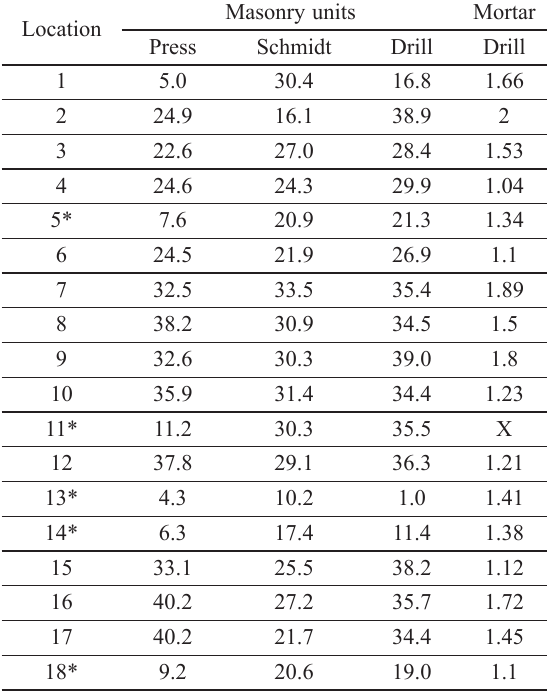
Fig. 5. Experimentally obtained relationships of compressive strength f u , exp and water content w hm for bricks and